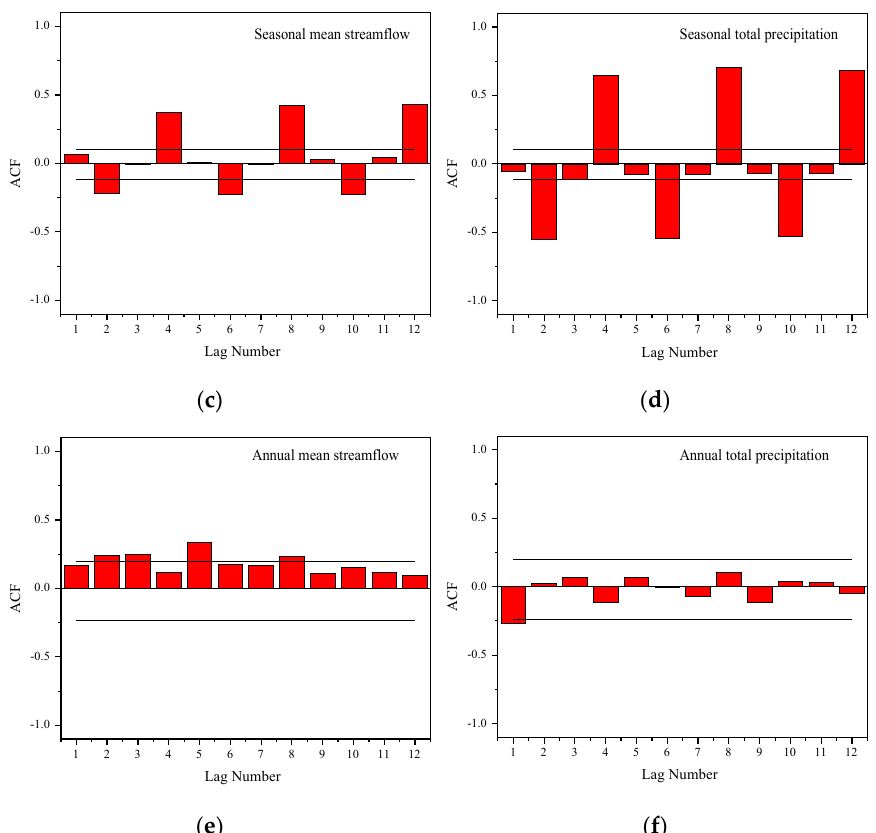
Figure 3. The correlograms of monthly, seasonal and annual series. The upper and lower solid lines represents the confidence intervals (95% confidence level). ( a ) monthly streamflow; ( b ) monthly precipitation; ( c ) seasonal streamflow; ( d ) seasonal precipitation; ( e ) annual streamflow; ( f ) annual precipitation.